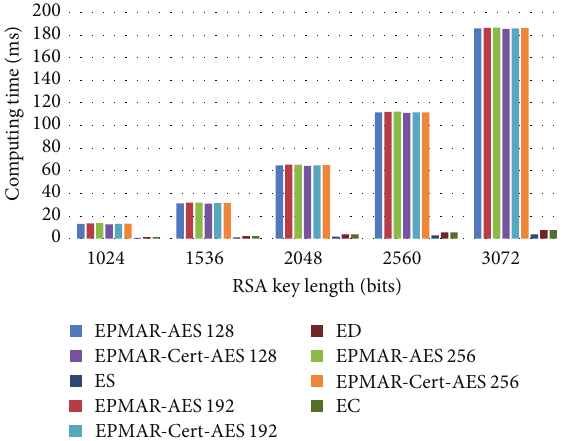
Figure 15: Reader’s computational time—online